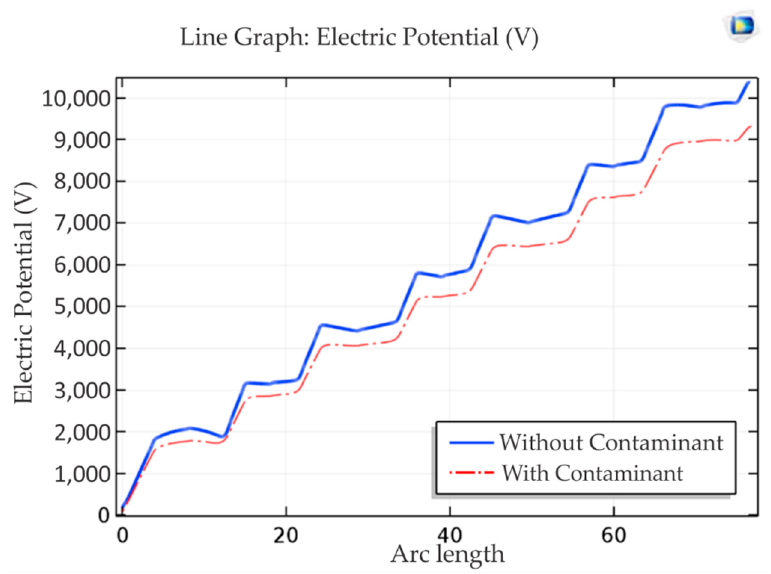
Figure 13. Voltage distribution comparison with and without contaminant.